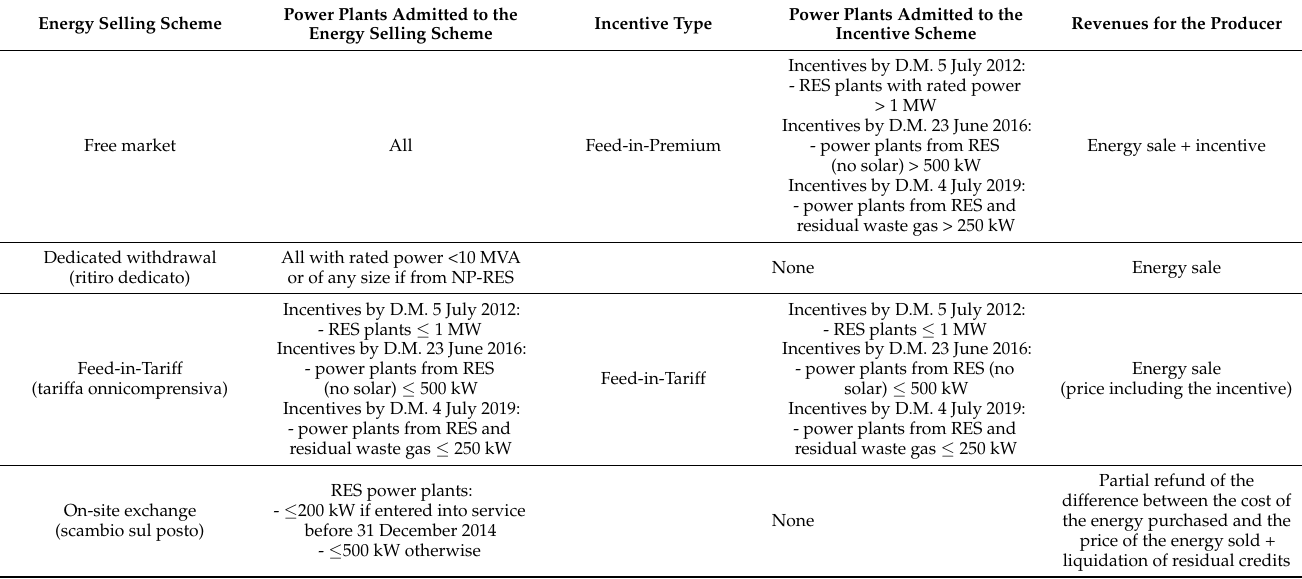
Table 1. Energy selling and incentive schemes in place in Italy for DERs since 2012